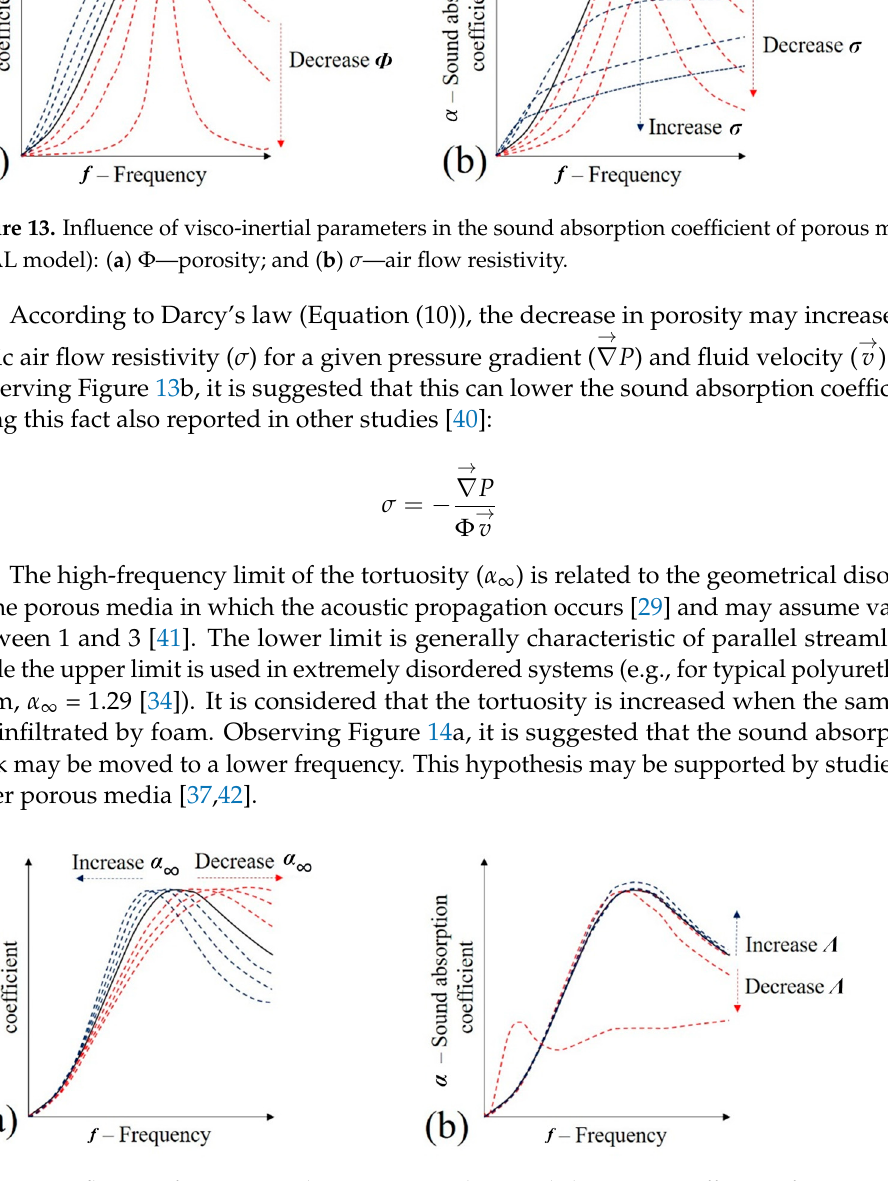
Figure 14. Influence of visco-inertial parameters in the sound absorption coefficient of porous media (JCAL model): ( a ) α ∞ —high-frequency limit of the tortuosity; and ( b ) Λ —viscous characteristic length.